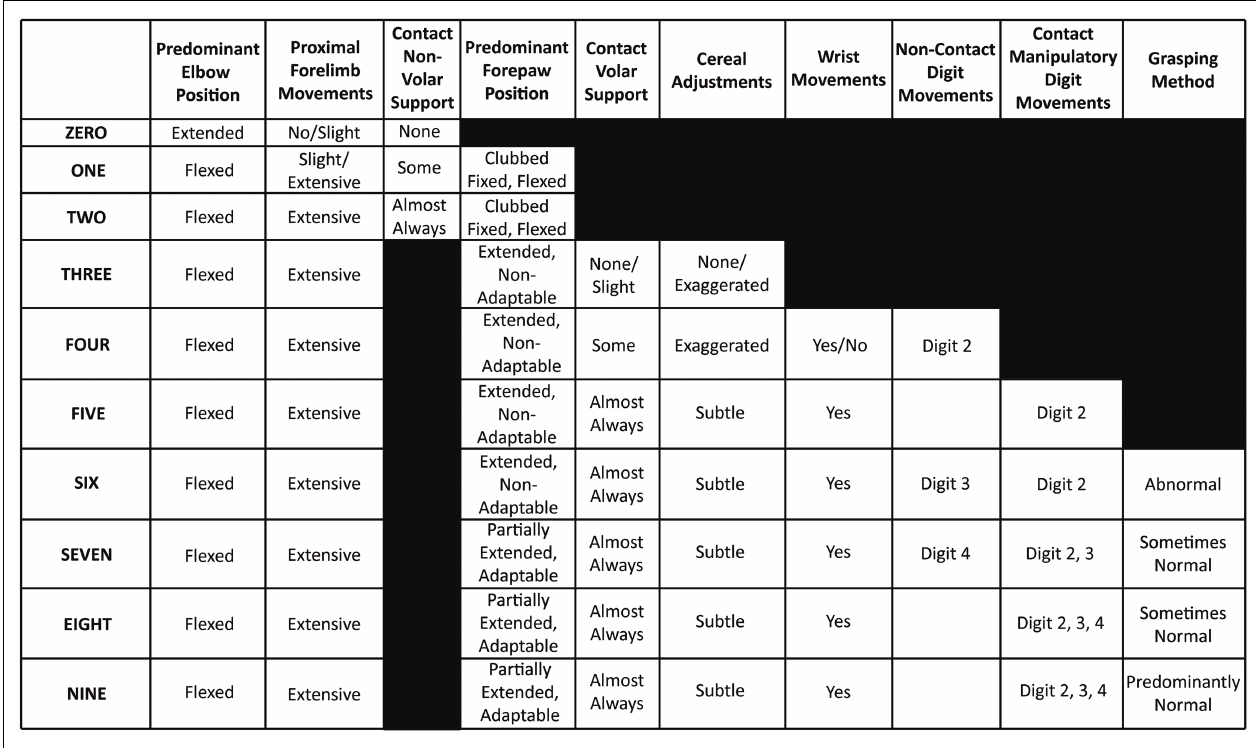
FIGURE 2 |The score determination guide .This guide can be used to aid in the selection of the correct IBB score after viewing the video and filling out the IBB score sheet.